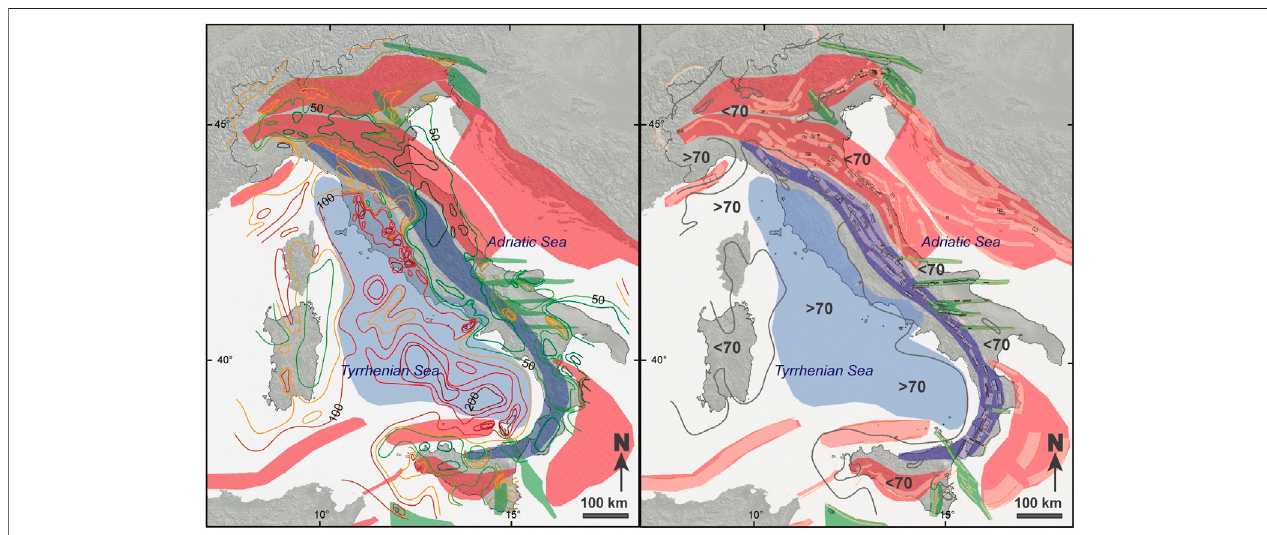
FIGURE3| Heat fl owmapofItalyfromCNR-IGG(seetextfordetails).Shadedareasindicateactivetectonicdomains(sameasin Figure2 ).Left-Completemodel, showing high/medium heat fl ow areas in the peri-Tyrrhenian belt (contours in red/orange). Contour spacing is necessarily variable as it re fl ects the original elaborations. Right-Outlineofthe70 mW/m 2 isoline(shownindarkgrey),usedinthisworkforseparatingareaswerethermallyanomalous fl uidsandCO 2 emissionsaremostlyrelated to high heat fl ow, to the west, from areas where they may represent the outcome of fl uid circulation in upper crustal rocks, to the east.